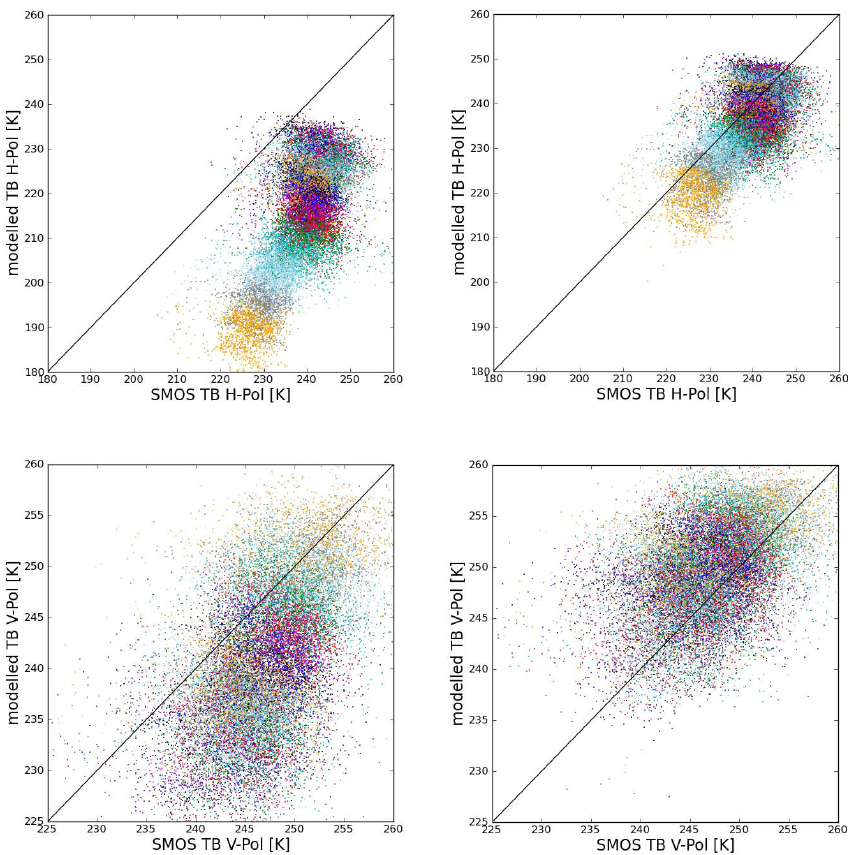
Fig. 4. Brightness temperatures as measured by SMOS vs. brightness temperatures as modelled with the model for one ice layer and the IceBridge ice thicknesses (left figures), and as modelled with the model for one ice and one snow layer and the IceBridge ice and snow thicknesses (right figures), respectively. The upper figures show horizontal polarisation, the lower figures vertical polarisation. The colors indicate the incidence angle increasing from 0 at the upper right corner to 60 ◦ at the lower left corner of the data cloud at horizontal polarisation, and from 0 at the lower left corner to 60 ◦ at the upper right corner at vertical